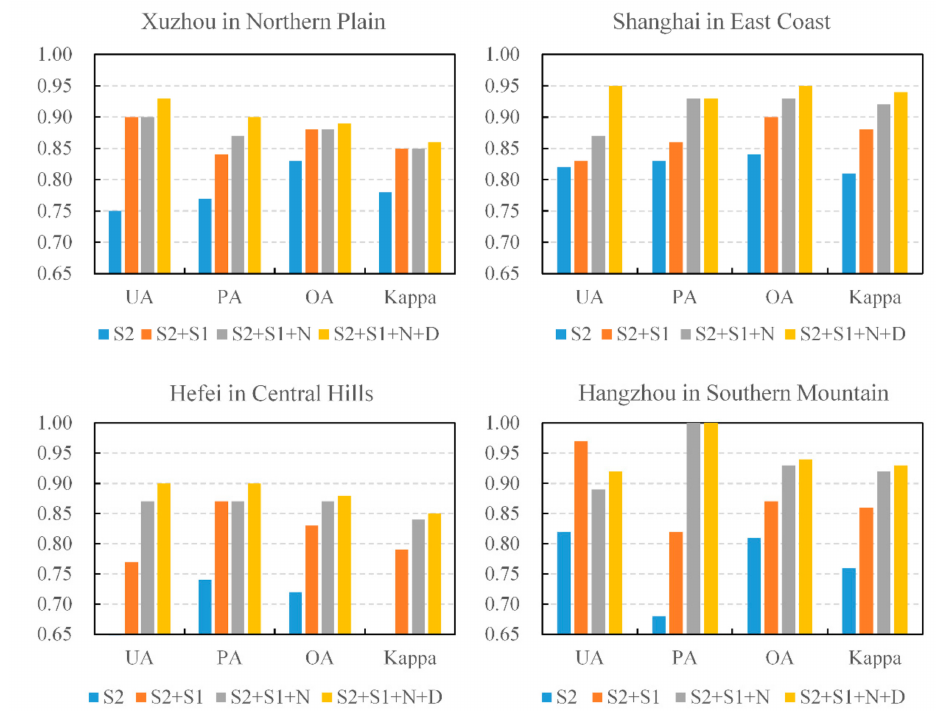
Figure 5. User’s accuracy (UA), producer’s accuracy (PA), overall accuracy (OA), and Kappa coe ffi cient of four input configurations in four training municipal districts. With more features added, higher accuracy was achieved.